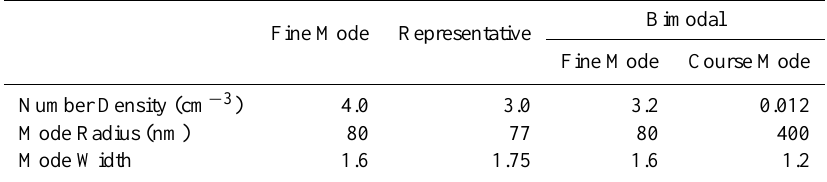
Table 1. Particle size distributions at 22.5km used to create Fig. 4. bimodal state. The shaded area shows error in the bimodal measurement vector due to 1% error in the measured